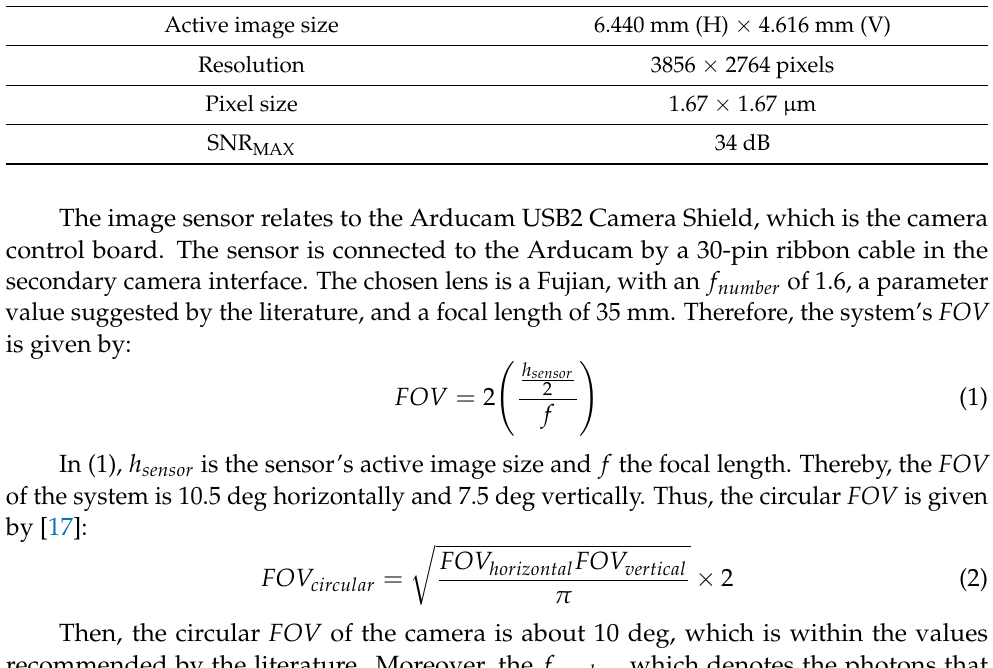
Table 2. Aptina MT9J001 specifications